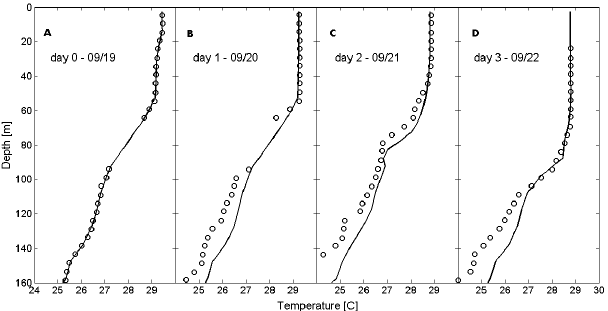
Figure 11. A comparison between the Argo profile temperature ob- servations (circles) and the 3DPWP model with typhoon Jangmi Fig. 11. A comparison between the Argo profile temperature observations (circles) and the 3 setup (black solid line). Four plots are presented (A–D) showing a 3DPWP model with typhoon Jangmi set up (black solid line). Four plots are presented (A-D) 4 comparison between 25 September (A) and 28 September (D) showing a comparison between September 25 (A) and September 28 (D). 5